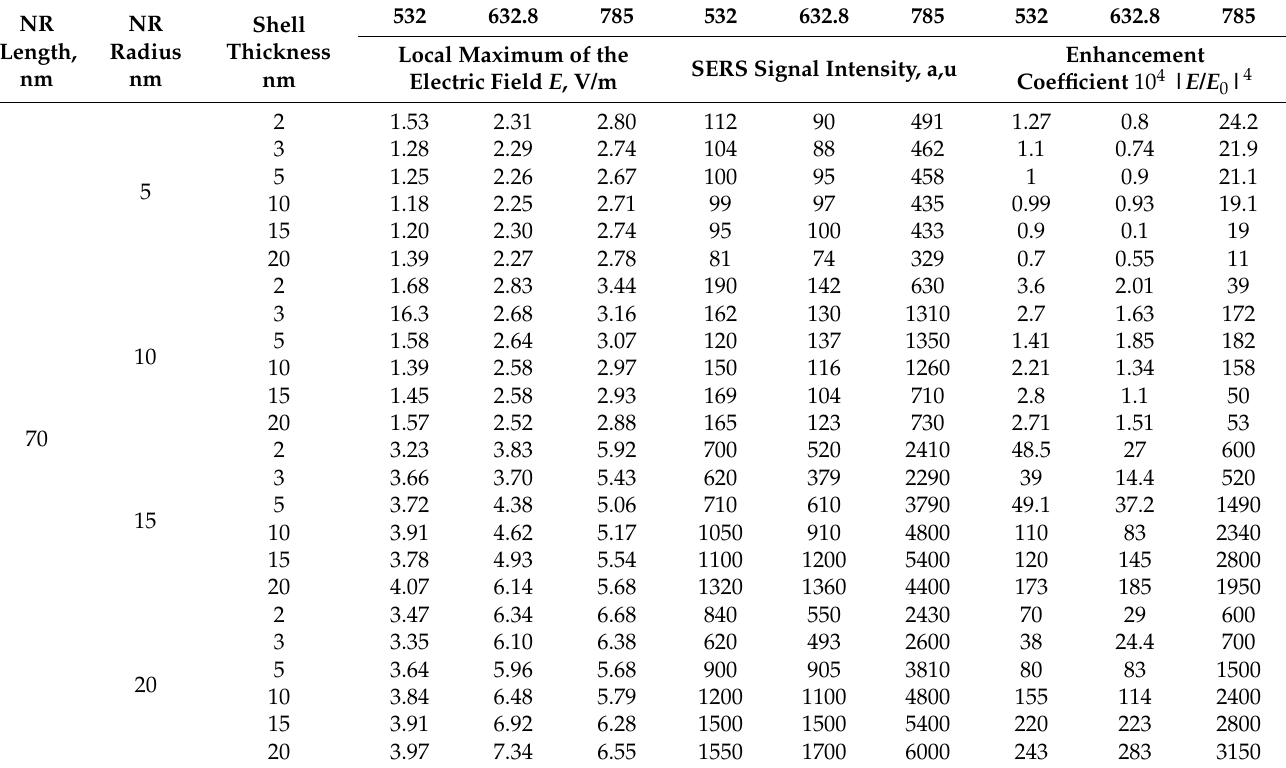
Table 3. Electric field simulation parameters for NRs with SiO 2